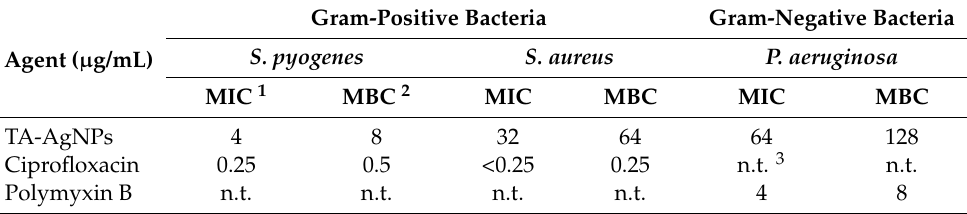
Table 2. MIC and MBC values of TA-AgNPs against bacteria causing wound infection.